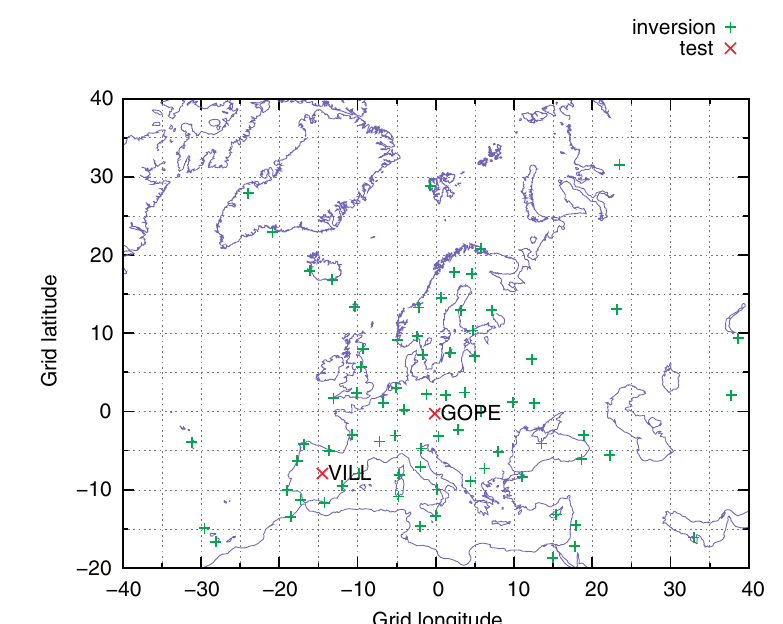
Fig. 1. Map of Europe, showing the test stations and those used for the